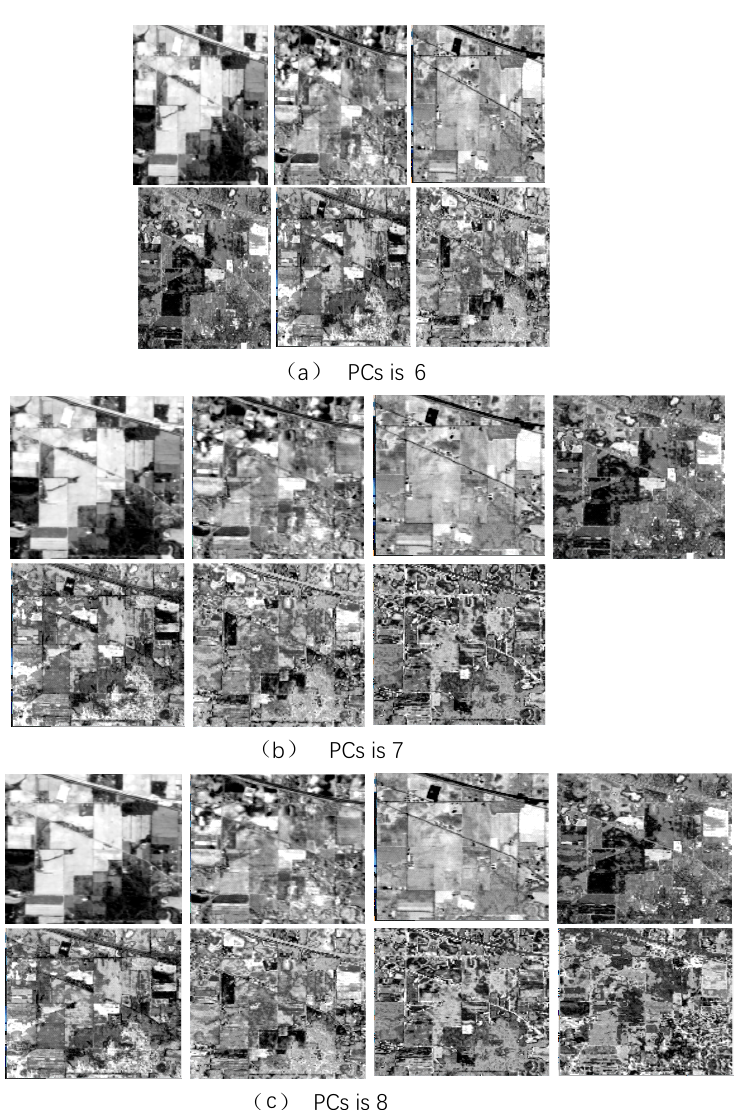
Figure 14. The Indian pines dataset shows the different band diagrams for different dimensionality dimensions. ( a ) for the 6-dimensional result graph, ( b ) for the 7-dimensional result graph, and ( c ) for the 8-dimensional result graph.